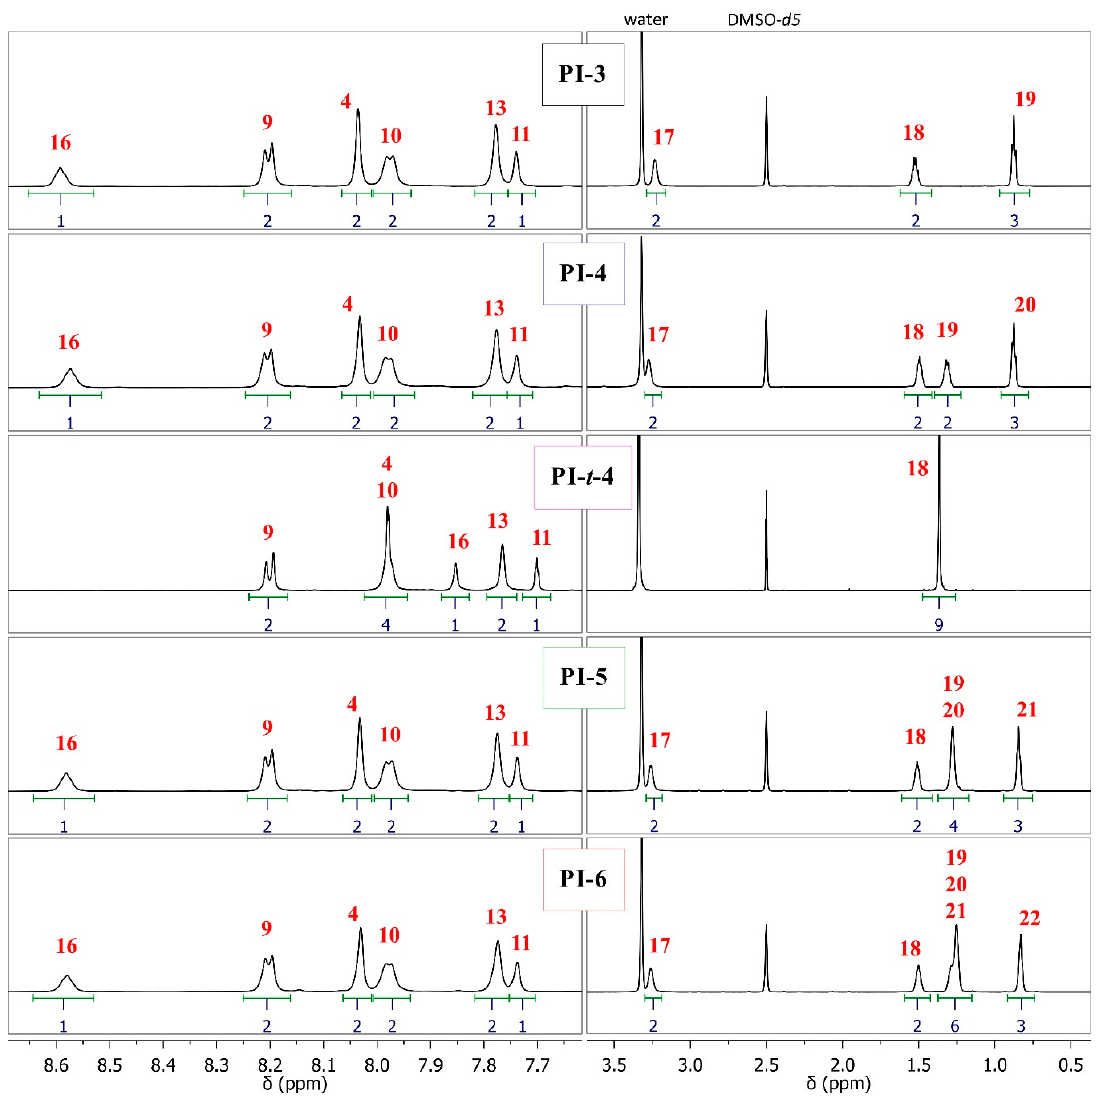
Figure 2. 1 H NMR spectra of all poly(imide)s.